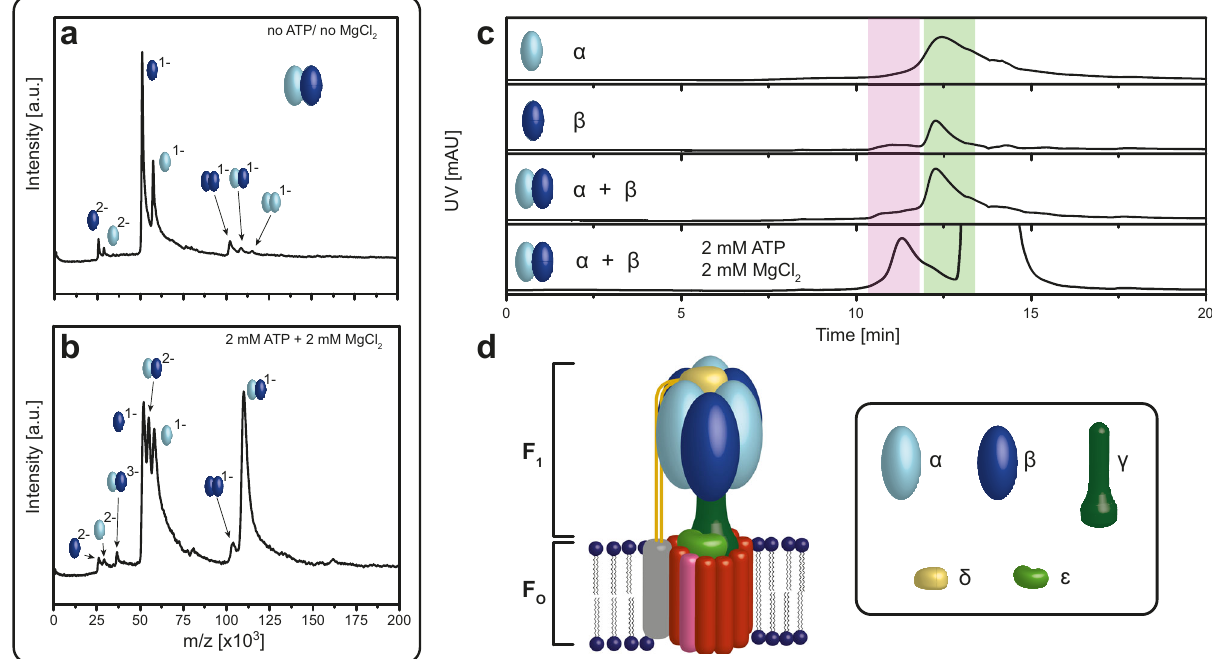
Fig. 1 Dependence of ATP/Mg 2 + in the assembly process of bacterial F-type ATP synthases. a , b LILBID spectrum of in vitro α and β assembly: the α - (light blue) and β -subunit (dark blue) either without a or with b 2 mM ATP and 2 mM MgCl 2 . In presence of ATP/Mg 2 + the mass spectrum shows the formation of a speci fi c αβ heterodimer assembly, but no higher αβ oligomers. c High-performance Liquid Chromatography (HPLC) of in vitro α (light blue) and β (dark blue) assembly: the addition of 2 mM ATP and 2 mM MgCl 2 to α and β lead to αβ heterodimer formation displayed by a shift from 12.27 min (light green area) to ~11.26 min (light red area). The elution peak at 13.25 min is owing to the high ATP concentration. d Model of bacterial F-type-ATPase: the soluble module F 1 is organized by α - (light blue), β - (dark blue), γ - (dark green), δ - (yellow) and ε -subunit (light green). Source data underlying a – c are provided as a Source Data fi